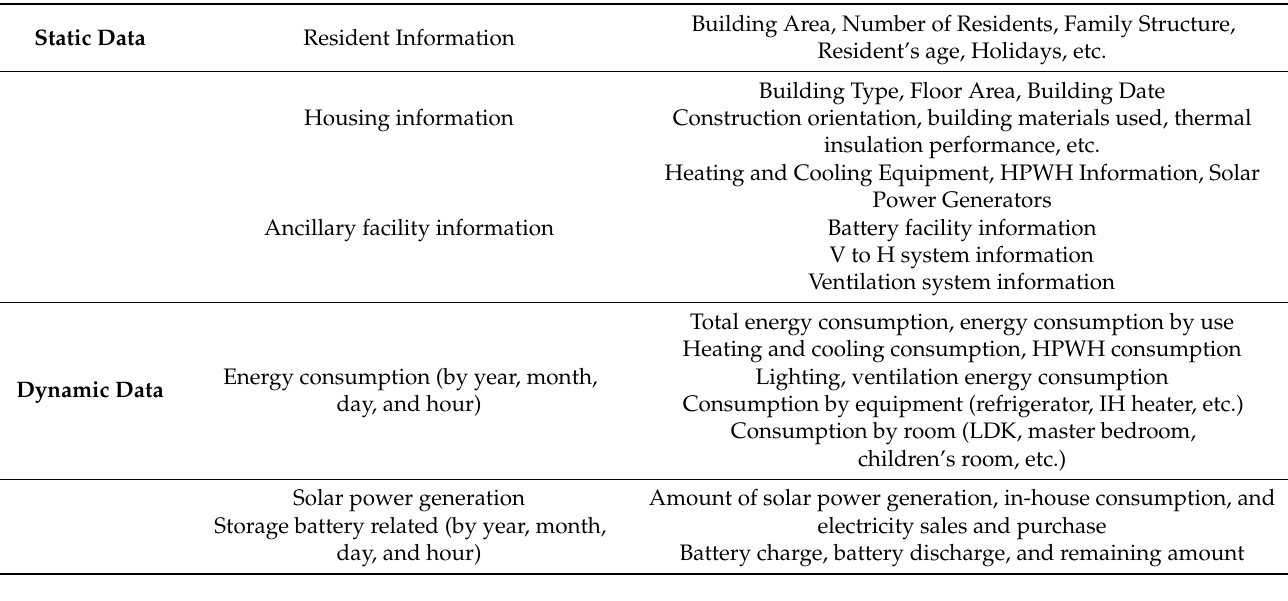
Table 2. HEMS users by energy conservation level